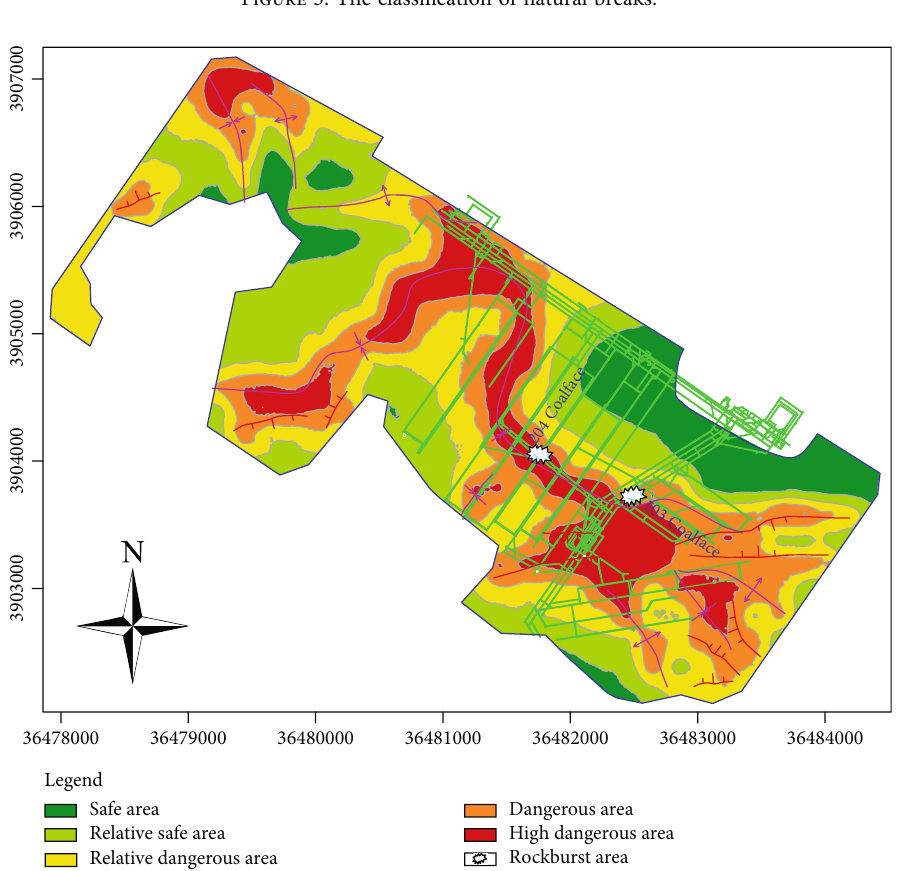
Figure 4: The zoning map of rockburst risk based on LS-FAHP-CRITIC